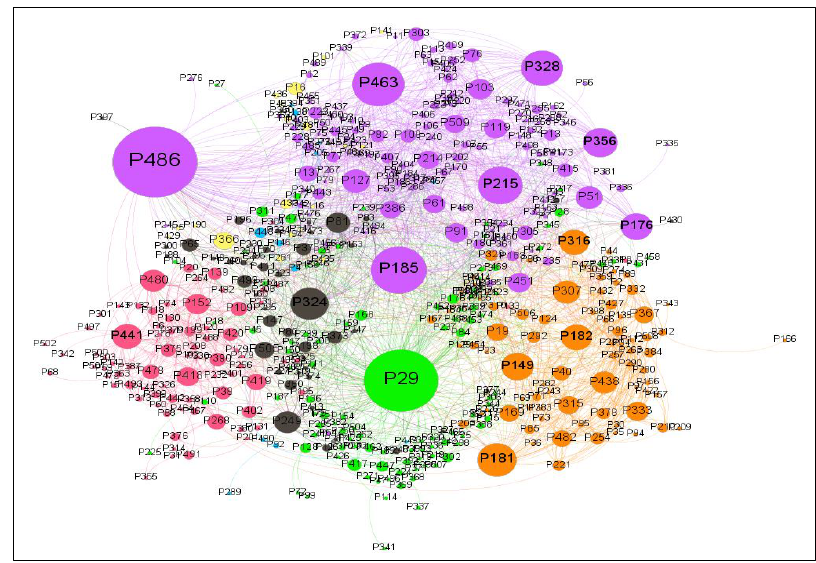
Figure 15. Community detection of citation networks.